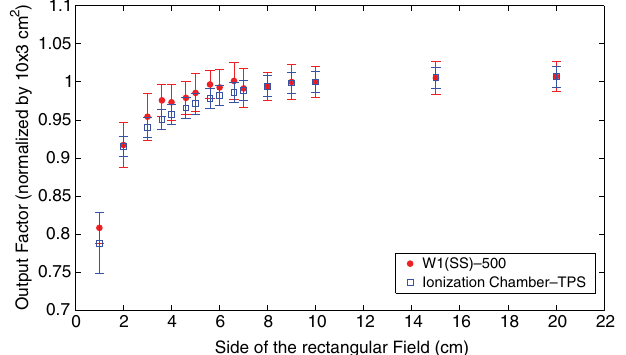
FIG. 10. Output factor measured with rectangular fields in the slab phantom.